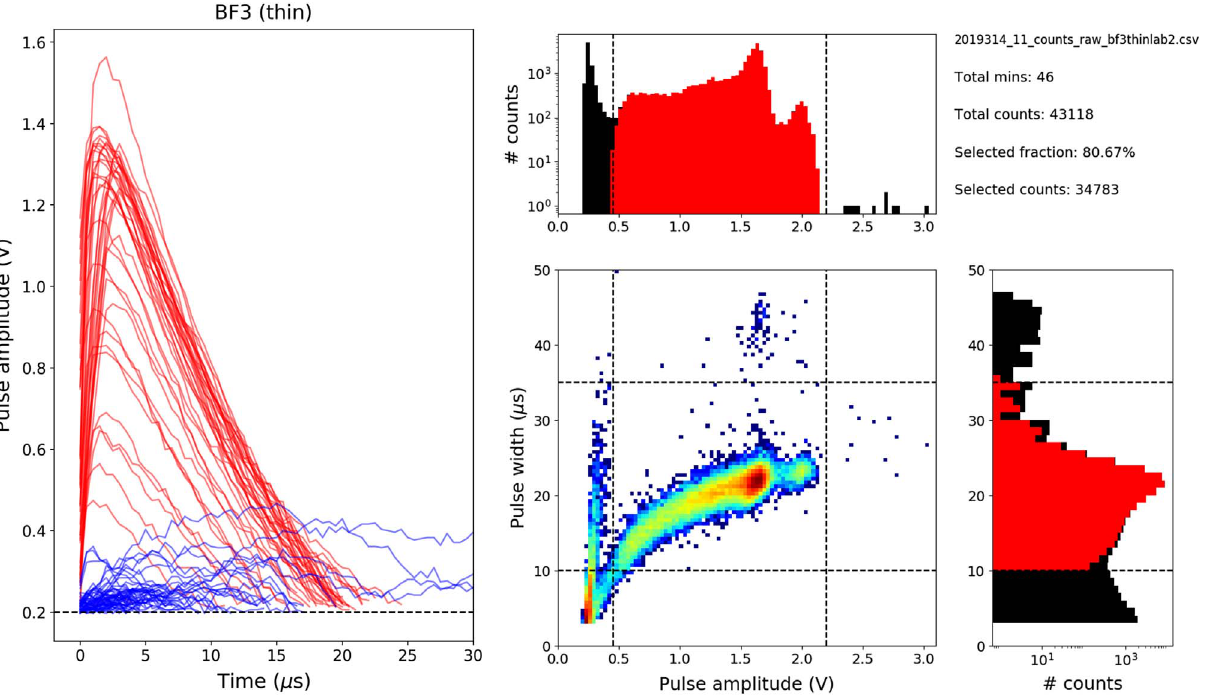
Fig. 4. Left panel: A selection of pulses registered from the thin BF 3 tube. Red pulses are assumed to be observations, while blue pulses indicate noise. Right panel: A 2D pulse width-amplitude histogram as registered from the same tube. The distribution is also projected onto each plane. The dashed lines show the cut applied to the pulses in order to discriminate between measurements and noise. On the projected histograms, all the pulses are indicated by a black histogram, while the red histogram indicated pulses assumed to be measurements free from